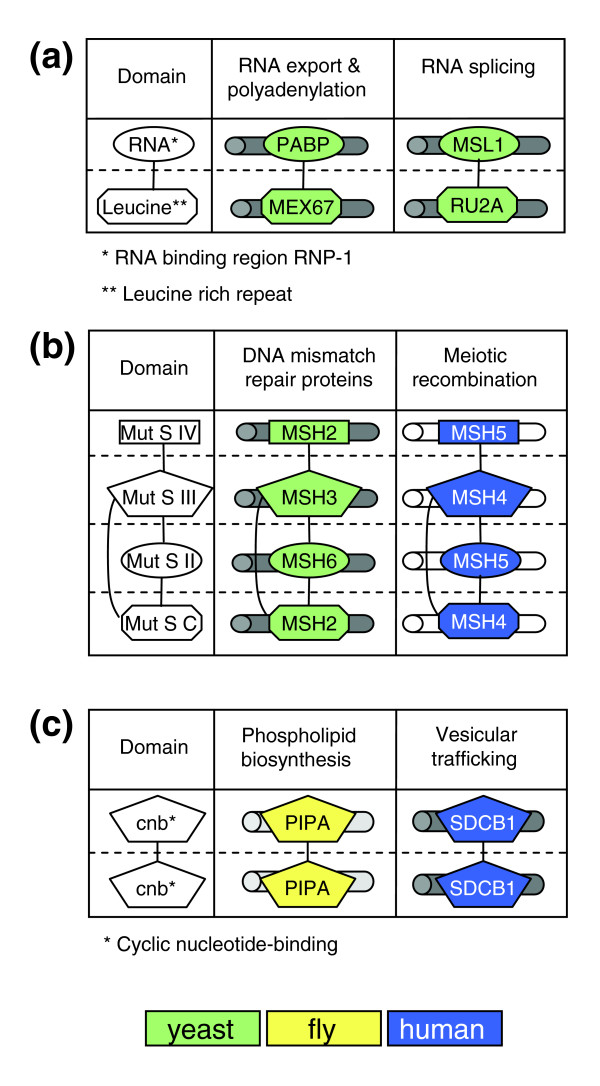
The same DDIs are used in different cellular contexts and in different organisms. The interacting domains (demonstrated and labeled in the left-most column) were mapped onto the interacting proteins (demonstrated and labeled in the two right columns). Edges connect between interacting domains/proteins. The proteins may be multidomain proteins, but only the relevant domain is demonstrated. (a) An example of the same DDI mapped onto two pairs of interacting proteins in yeast, which are involved in different processes, namely RNA export and RNA splicing. (b) An example of a subnetwork of four proteins whose interactions are attributed to the same DDIs in S. cerevisiae and in human. In yeast, the interacting proteins are involved in DNA mismatch repair and in human they are involved in meiotic recombination. The proteins MSH4 and MSH5 are not considered homologs of the proteins MSH2, MSH3, or MSH6 (based on the report by Altschul and coworkers [40] and on sequence comparison). (c) An example of two PPIs attributed to the same DDI in different processes in D. melanogaster and human; in fly it is involved in phospholipid biosynthesis and in human in vesicular trafficking. These examples emphasize the modularity of DDIs and their possible role as the 'building blocks' of the PPI networks. The Swiss-Prot accessions of the proteins are as follows: PABP: [P04147]; MEX67: [Q99257]; MSL1: [P40567]; RU2A: [Q08963]; MSH2: [P25847]; MSH3: [P25336]; MSH6: [Q03834]; MSH5: [O43196]; MSH4: [O15457]; SDCB1: [O00560]; and PIPA: [P13217]. DDI, domain-domain interaction; PPI, protein-protein interaction;. fly, D. melanogaster; yeast, S. cerevisiae.